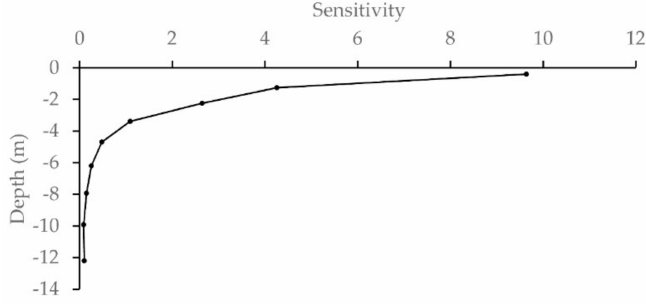
Figure 5. Average sensitivity in the middle part of the 3D ERT set-up (i.e., at well W2